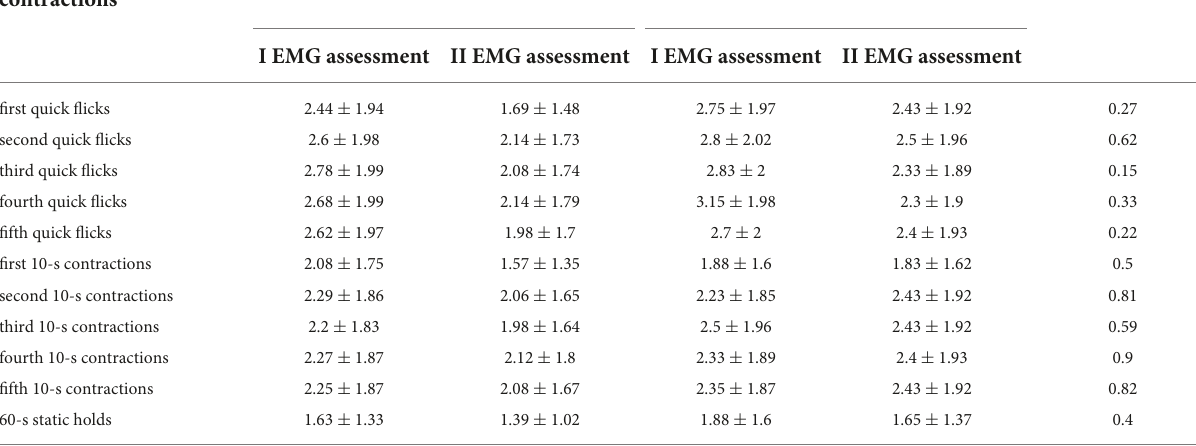
TABLE 2 The firing order of the pelvic floor muscles (PFMs) in selected motor tasks before and after a single electromyography (EMG) biofeedback session in the biofeedback and control. Motor tasks for PFM